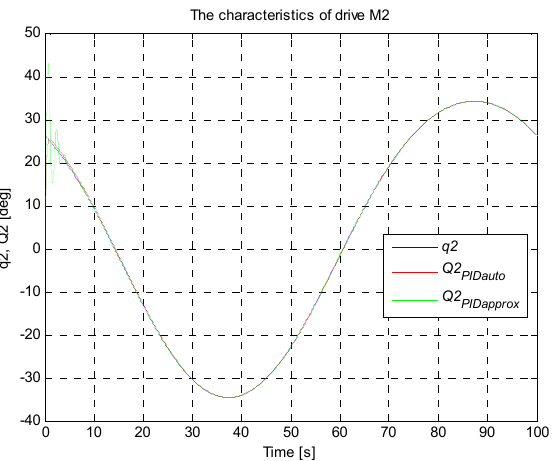
Figure 19. The courses of set and controlled configurational variables for the drive of the second arm.